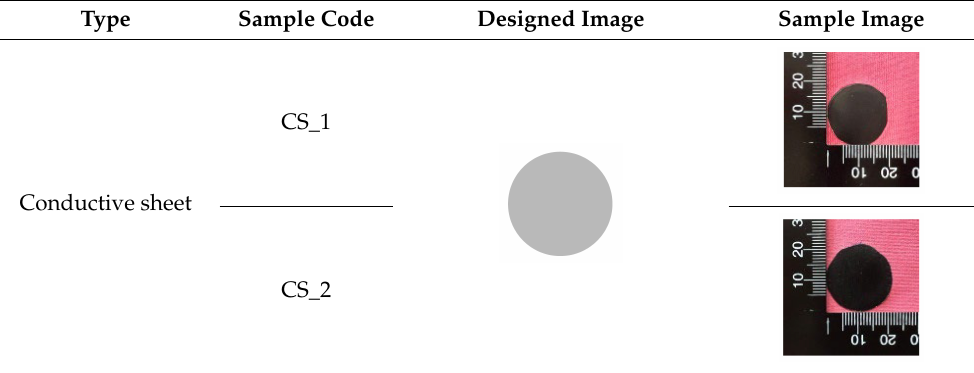
Table 1. Sample code and images of the textile-based dry electrode used in this